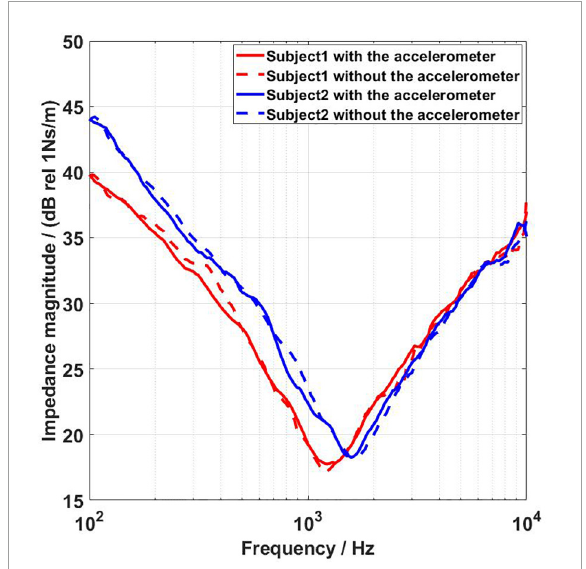
FIGURE12 Results of mastoid impedance measurements in two subjects.